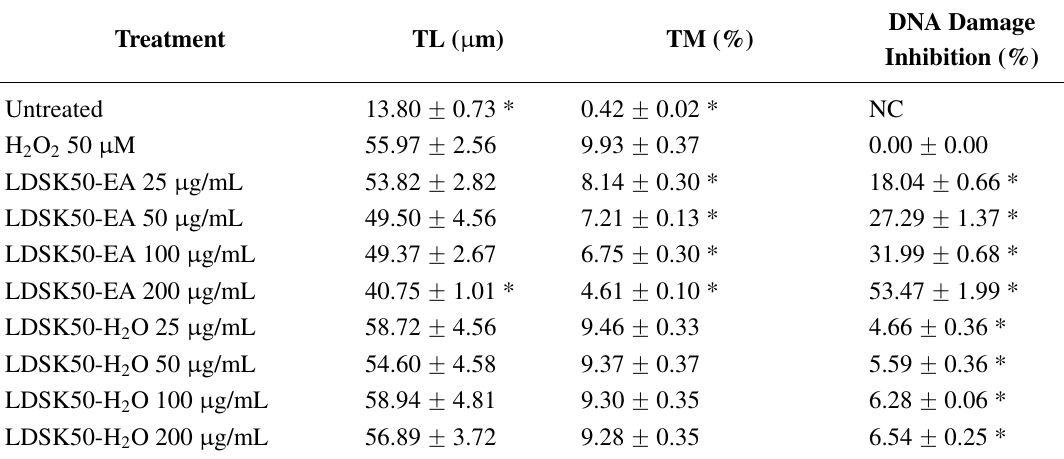
O in TK6 cells by 2